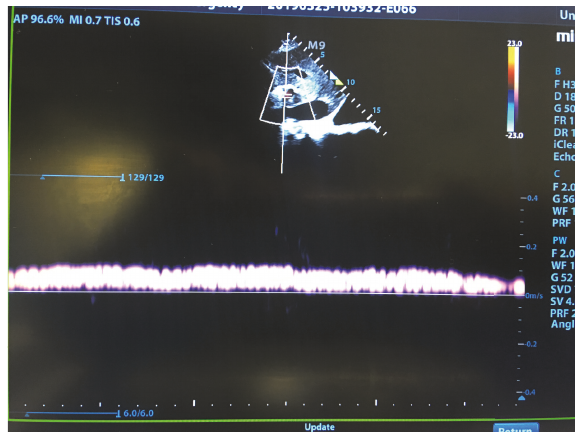
Figure 3: Biphasic portal vein Doppler profile with flow reversal performed on day 1. Pulsatility fraction more than 100 % with heart rate at 95 bpm.